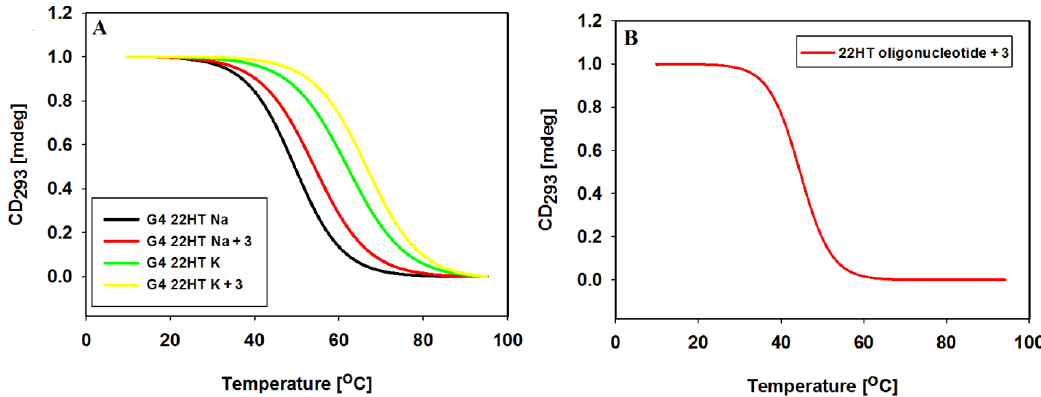
Figure 11. Normalized CD melting profiles of 22HT G-quadruplex at 293 nm without and with 3 equiv. of ligand 3 in 10 mM Tris-HCl buffer (pH 7.2) containing 100 mM NaCl and 100 mM KCl ( A ); Panel ( B) shows normalized CD melting profiles of 22HT oligonucleotide at 293 nm with 3 equiv. of ligand 3 in 10 mM Tris-HCl buffer (pH 7.2).